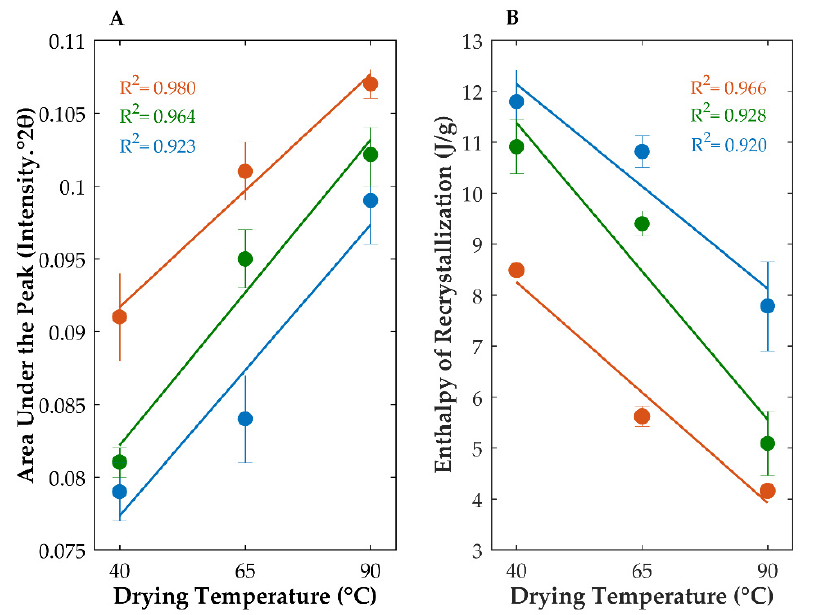
Figure 3. Influence of the drying temperature on the extent of recrystallization of amorphous olanzapine when 10% (blue), 25% (green) or 40% (orange) of water were applied to mixtures, as determined by X-ray powder diffraction ( A ) and differential scanning calorimetry ( B ).